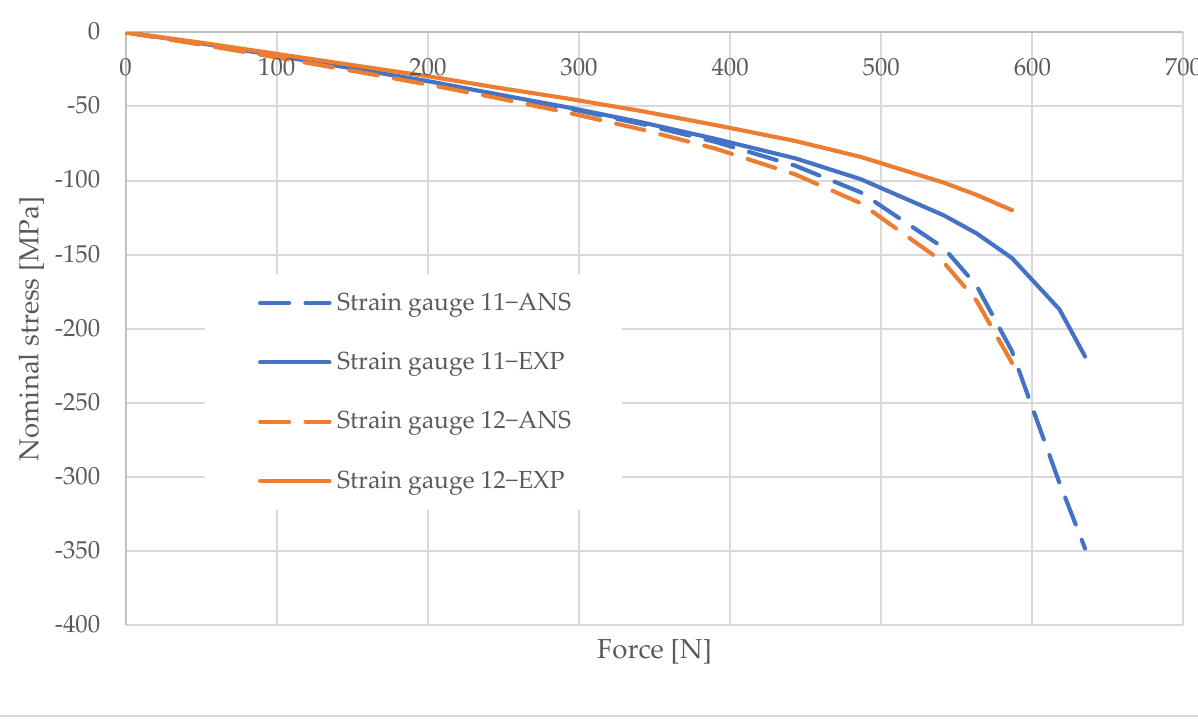
Figure 11. Pole 5/2 — values of normal stress readings from strain gauges no. 11 and 12. Figure 11. Pole 5/2—values of normal stress readings from strain gauges no. 11 and 12.